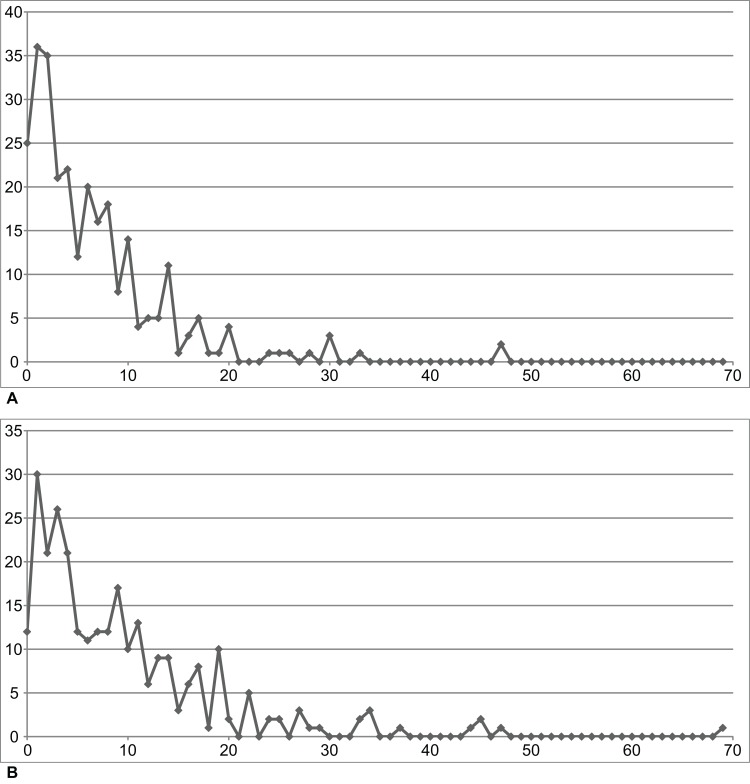
Homoplasy distribution in our matrix.The number of extra steps (x-axis) is the number of observed steps (in Mesquite, on the tree in Data S3 for each analysis) minus the minimum possible number of steps, which is the number of states minus one (for ordered and unordered characters as well as for both of our stepmatrix characters). The number of characters that have each number of extra steps is plotted on the y-axis. The line between the data points is meaningless, but makes it easier to compare the distributions to an exponential curve. Compare Goloboff, Torres & Arias (2018: fig. 1(a)). (A) Original taxon sample (Analysis R1); the highest number of extra steps is 47, but we plot to 69 for comparison to (B). (B) Expanded taxon sample (Analysis R4); the highest number of extra steps is 69.